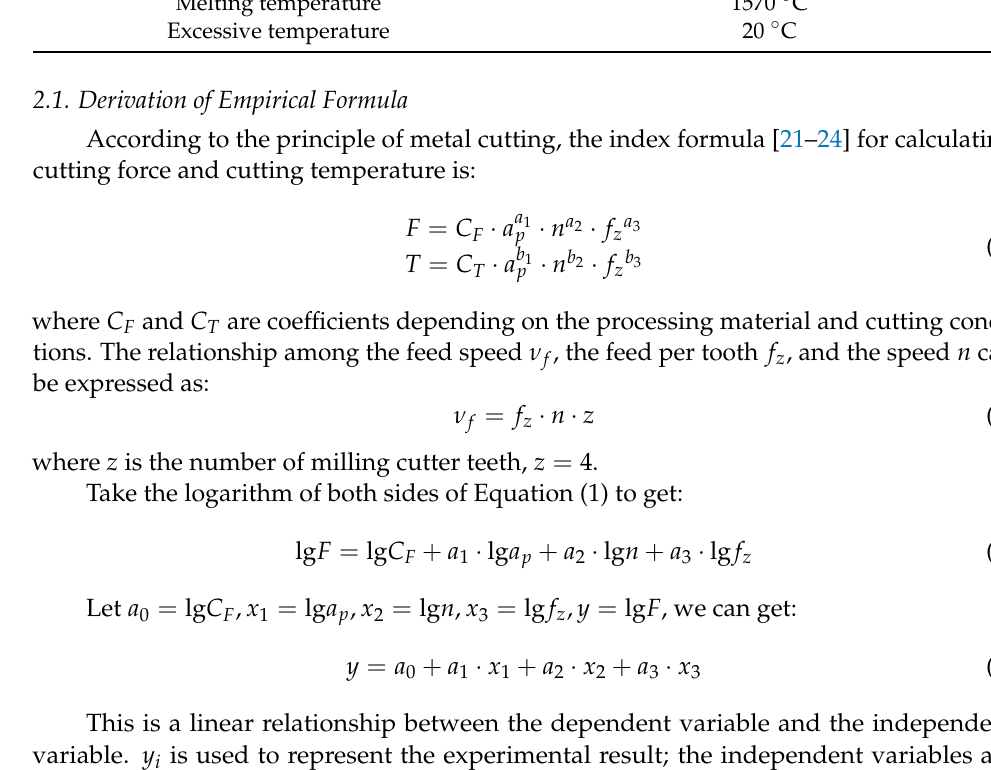
Table 1. Johnson-Cook plasticity parameters of Inconel718. A 450 MPa B 1700 (cid:0) . ε 0 = C